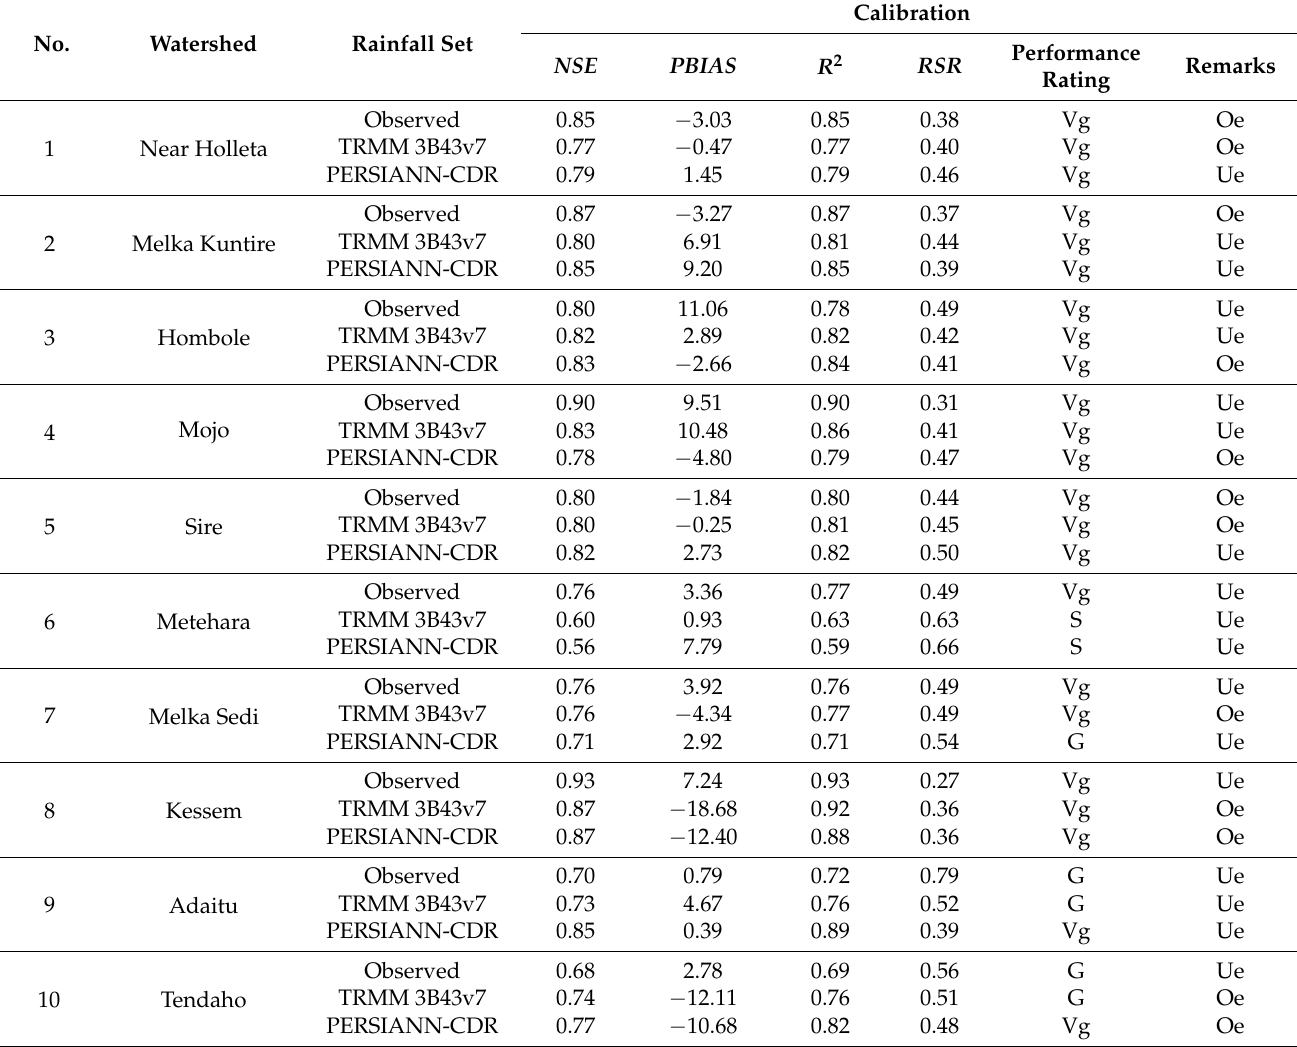
Table 4. Comparison of statistical evaluation criteria for the calibration of hydrologic data.